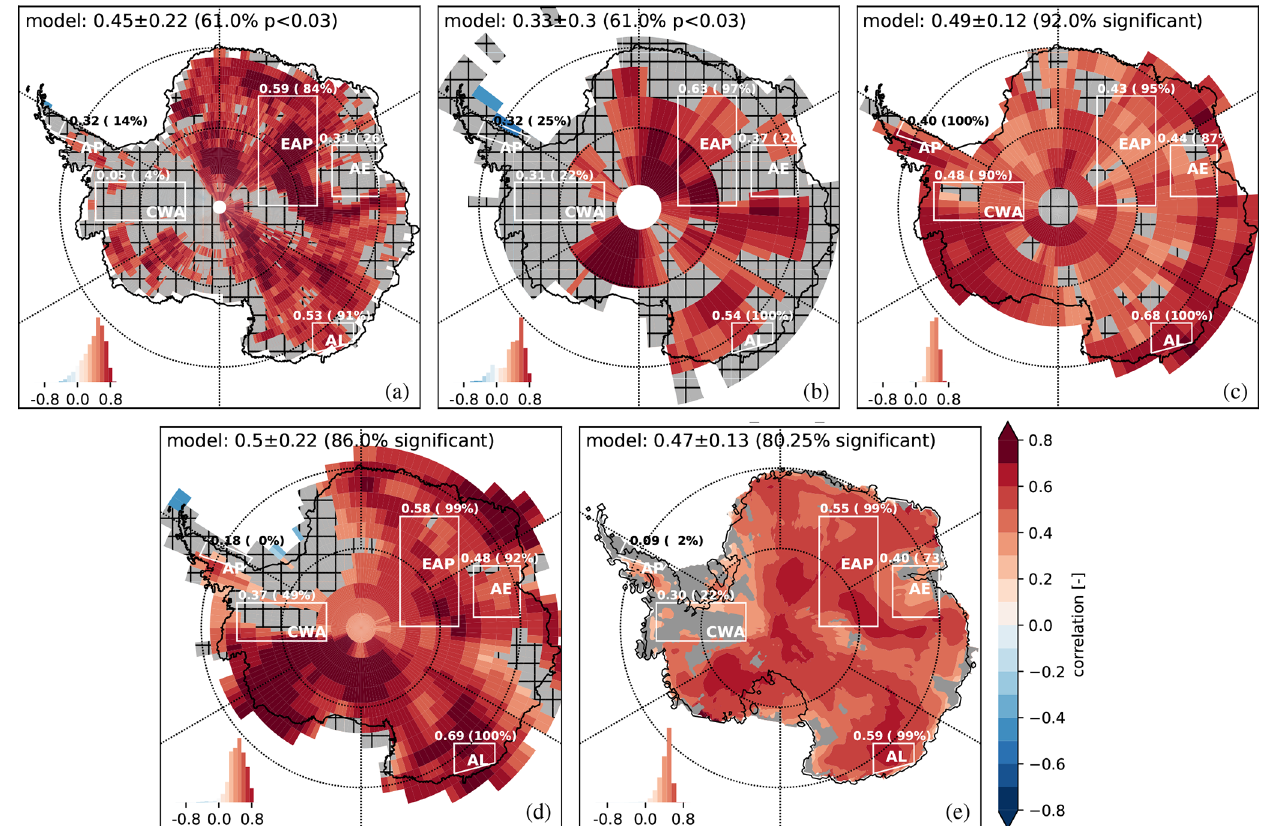
Figure 2. The 5-yearly correlation between SMB and δ 18 O over 1871–2000 for (a–e) : (a) ECHAM5-wiso, (b) ECHAM-MPI/OM, (c) iHadCM3 (seven-simulation average), (d) iCESM1 (three-simulation average), (e) averaged over all the isotopic GCMs. Statistically in- significant areas ( p > p FDR , the threshold p value calculated) are in grey. The histogram displays the distribution of correlation values. Continent-wide annual correlation mean, standard deviation, and percentage of model area with p < p FDR are provided in each panel (for e , average over all four isotopic GCMs). The five regions mentioned are annotated as in Fig.